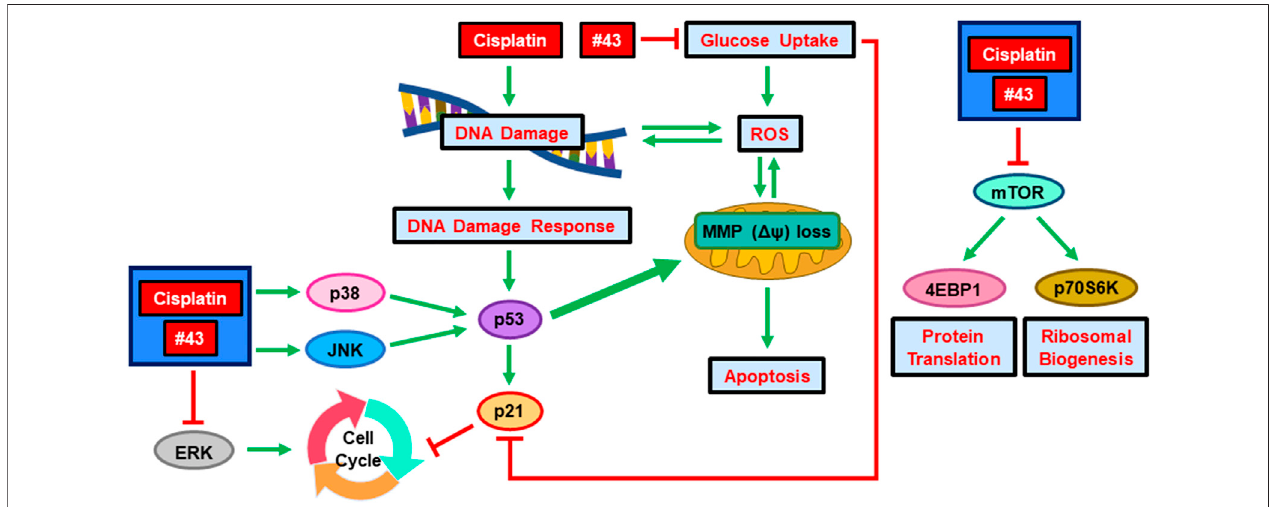
FIGURE 8 | Schematic diagram of the potential molecular mechanisms underlying the synergism of cisplatin and a novel GLUT1 inhibitor #43. Green arrows indicate induction and red lines denote inhibition.